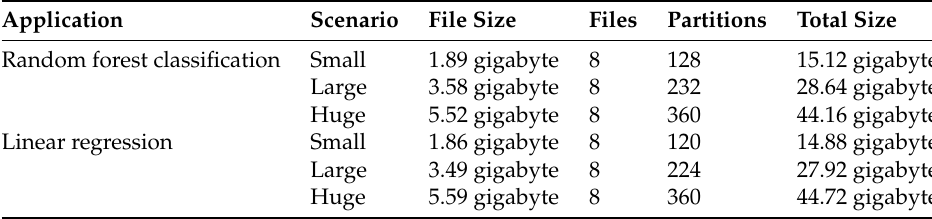
Table 3. Data workload scenarios and